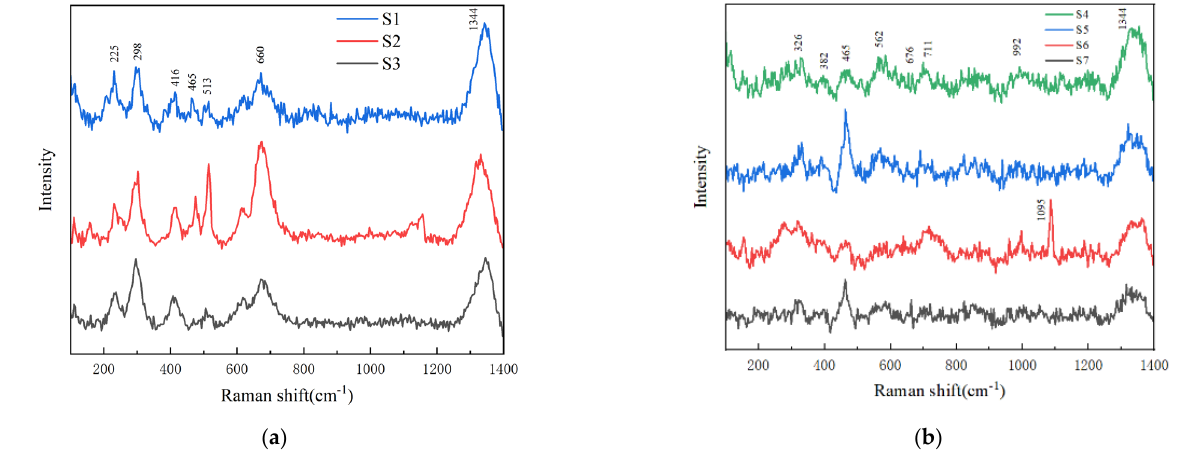
Figure 7. Raman spectra of clinker bricks. ( a ) S1–S3; ( b ) S4–S7.